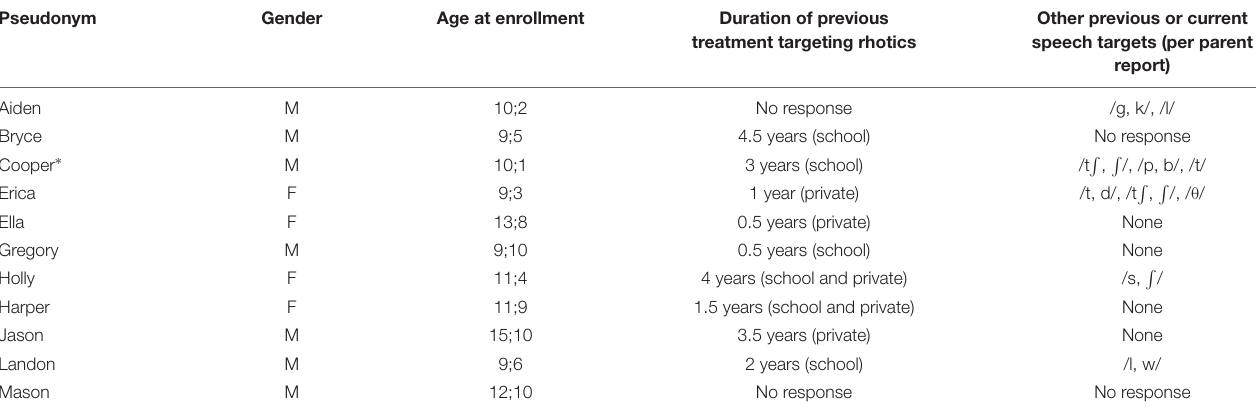
TABLE 1 | Participant background data, per parent report.